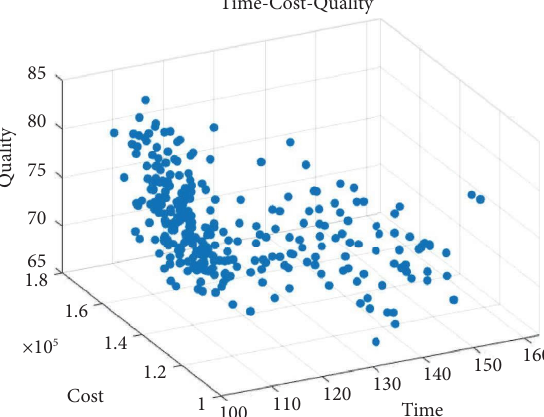
Figure 21: Time-cost-quality